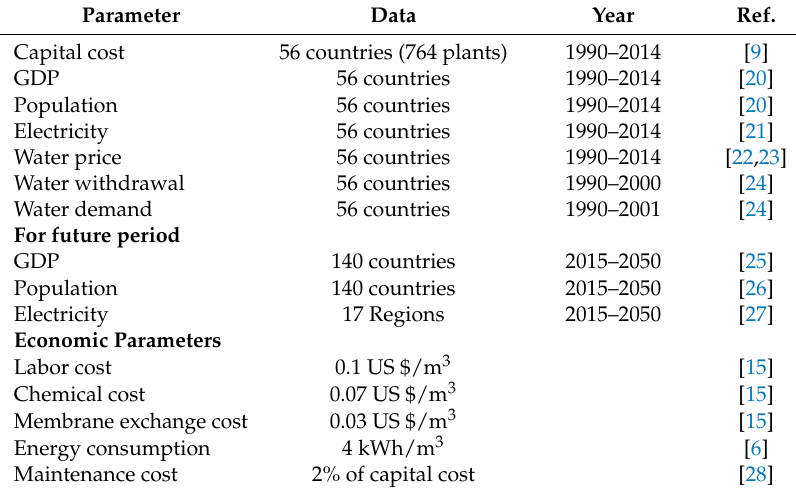
Table 1. Socioeconomic parameters and data used in the